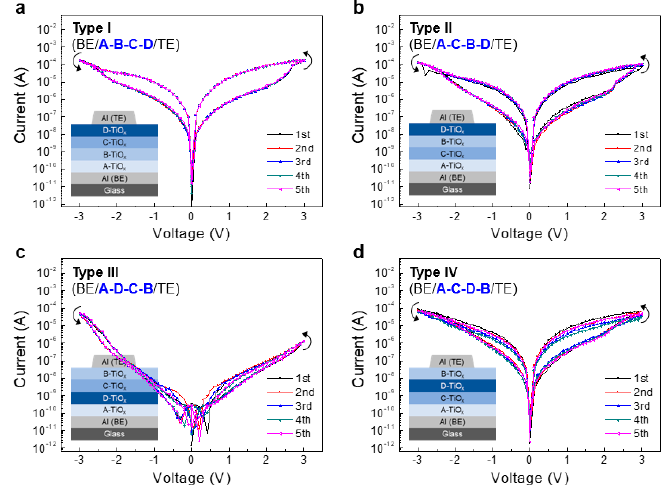
Figure 2. The representative current–voltage (I–V) characteristics of memristors having the stacking sequences of ( a ) A-B-C-D (type I), ( b ) A-C-B-D (type II), ( c ) A-D-C-B (type III), and ( d ) A-C-D-B (type